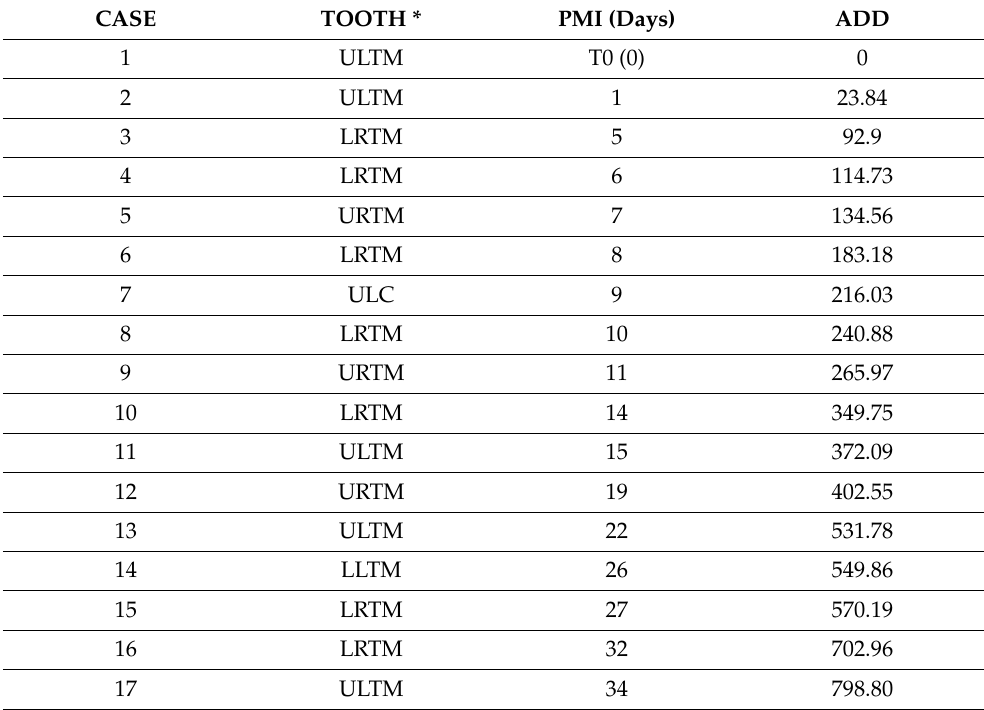
Table 1. Data set of eligible samples. Tooth position, PMI and